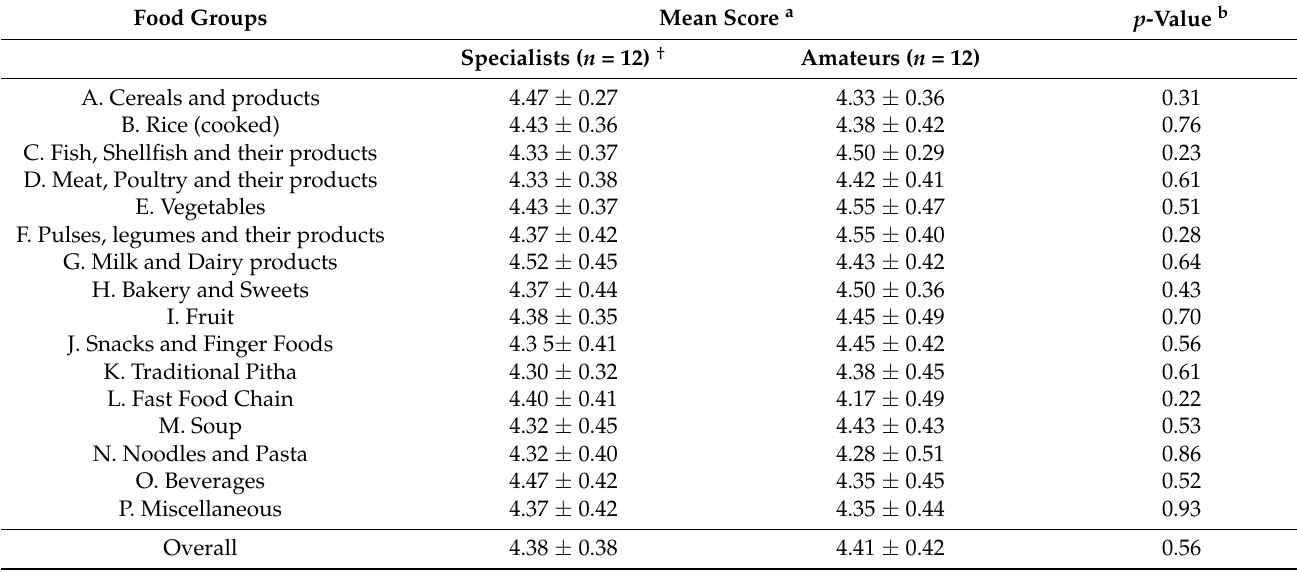
Table 1. Respective food group scores of specialists and amateurs.